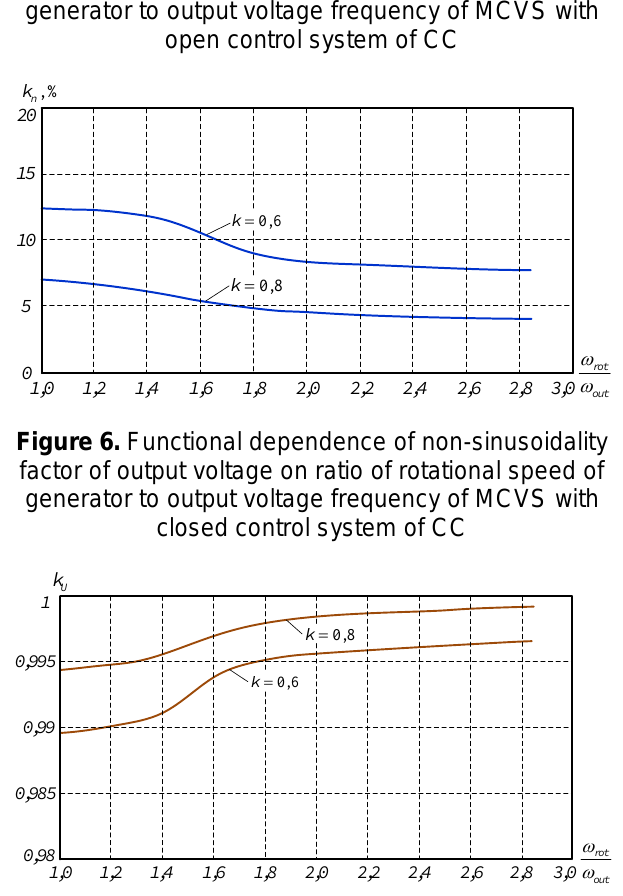
Figure 5. Functional dependence of non-sinusoidality factor of output voltage on ratio of rotational speed of generator to output voltage frequency of MCVS with